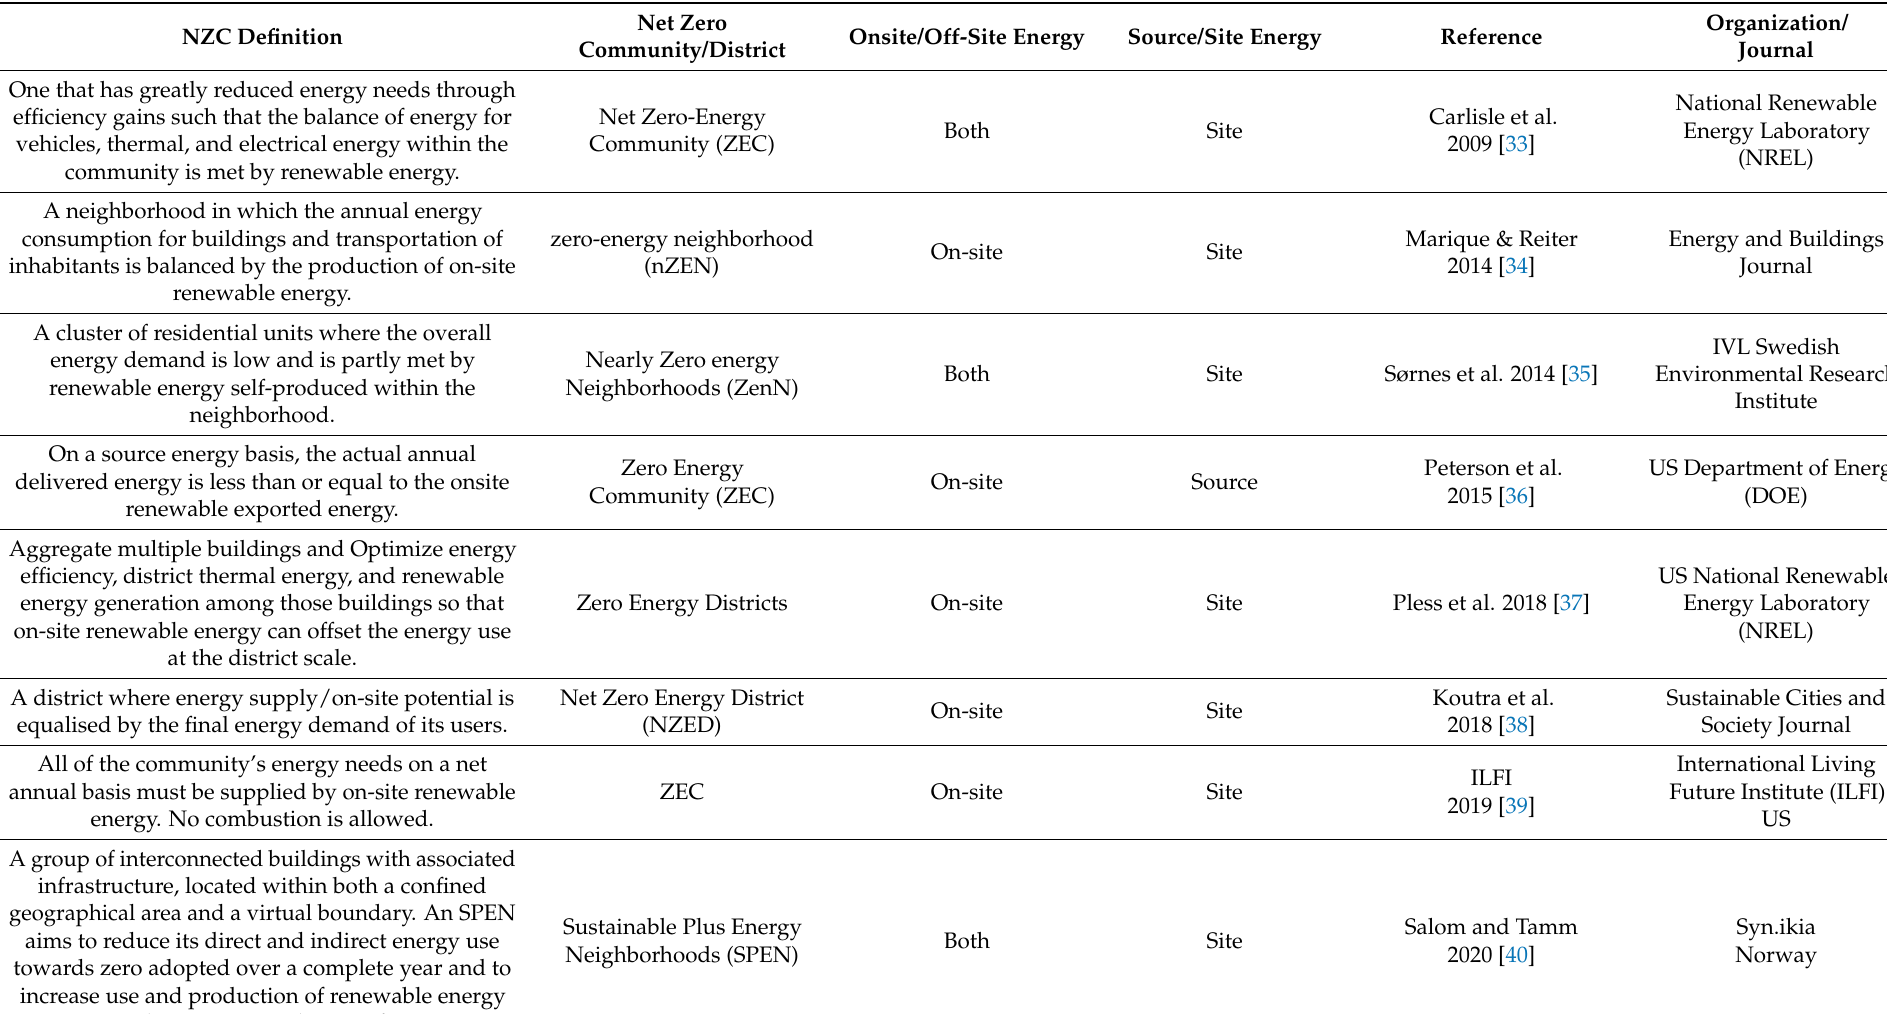
Table 1. Variations in the current net zero community